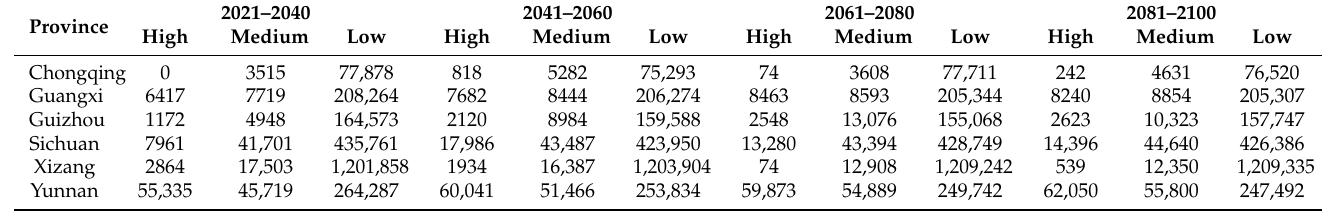
Table 2. Areas (km 2 ) of different environmental suitability over the next 80 years in China by province. Red text indicates increases and blue text indicates decreases (relative to the previous 20 years).